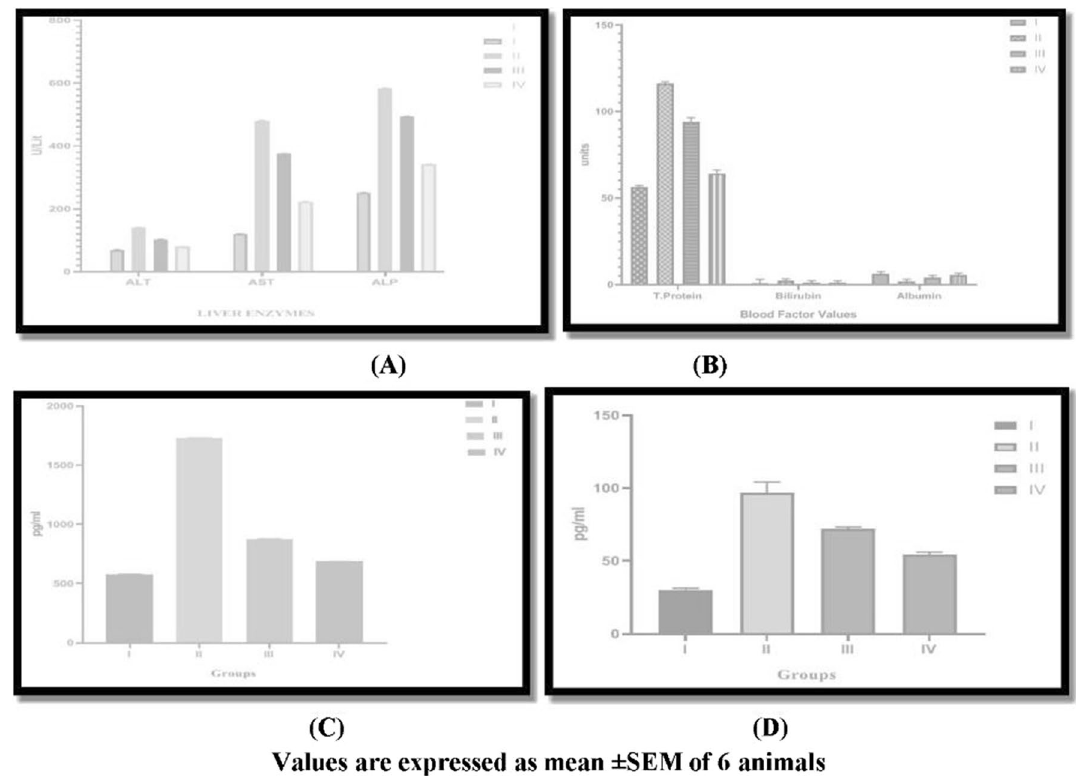
Fig. 14 Effect of Trichoderma viride crude extract on biochemical parameters. Group I (control) II (DES treated), Group III ( Trichoderma viride extract 20 mg/kg) and IV ( Trichoderma viride extract 40 mg/kg) ANOVA, followed by Dunnett’s “ t ” test.** p < 0. 01. ns represents non-significance. ( A —liver enzymes, B —total protein, bilirubin and albumin, C —TNF-α and D